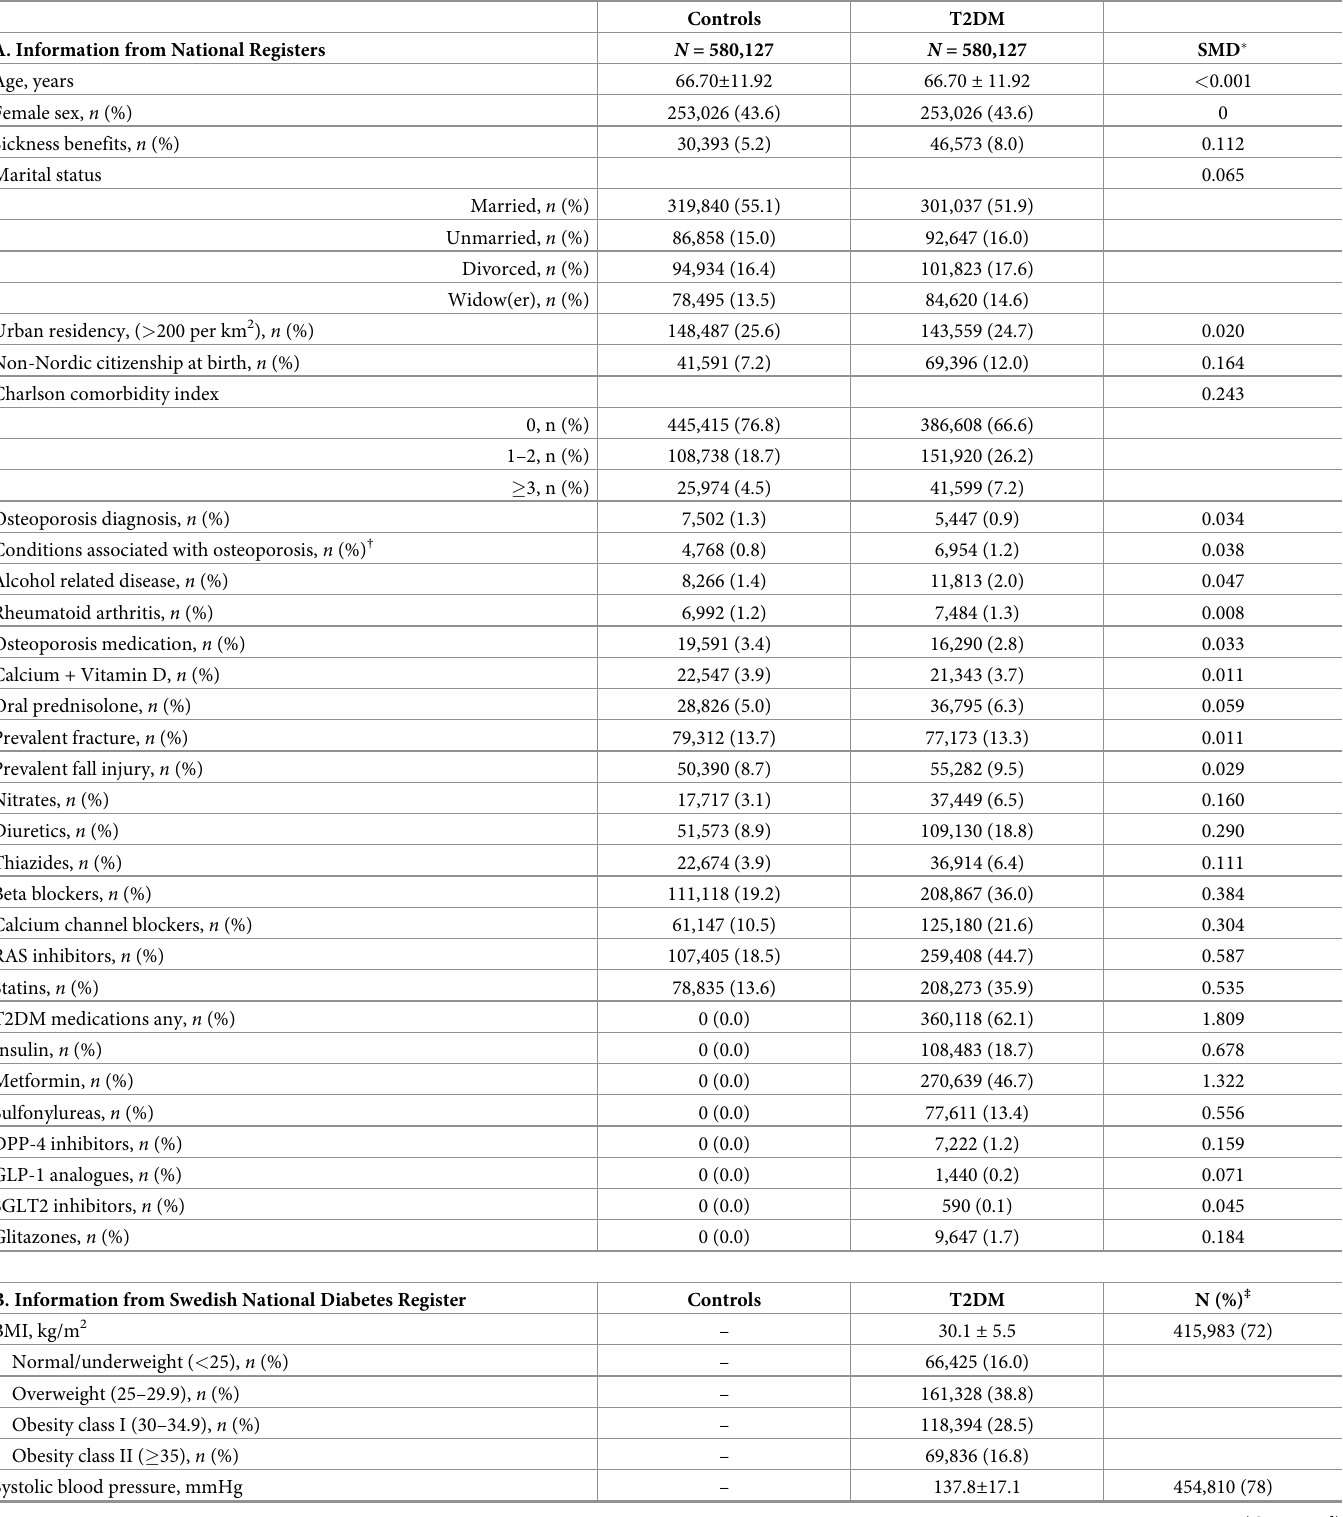
Table 1. Baseline characteristics of patients with type 2 diabetes and